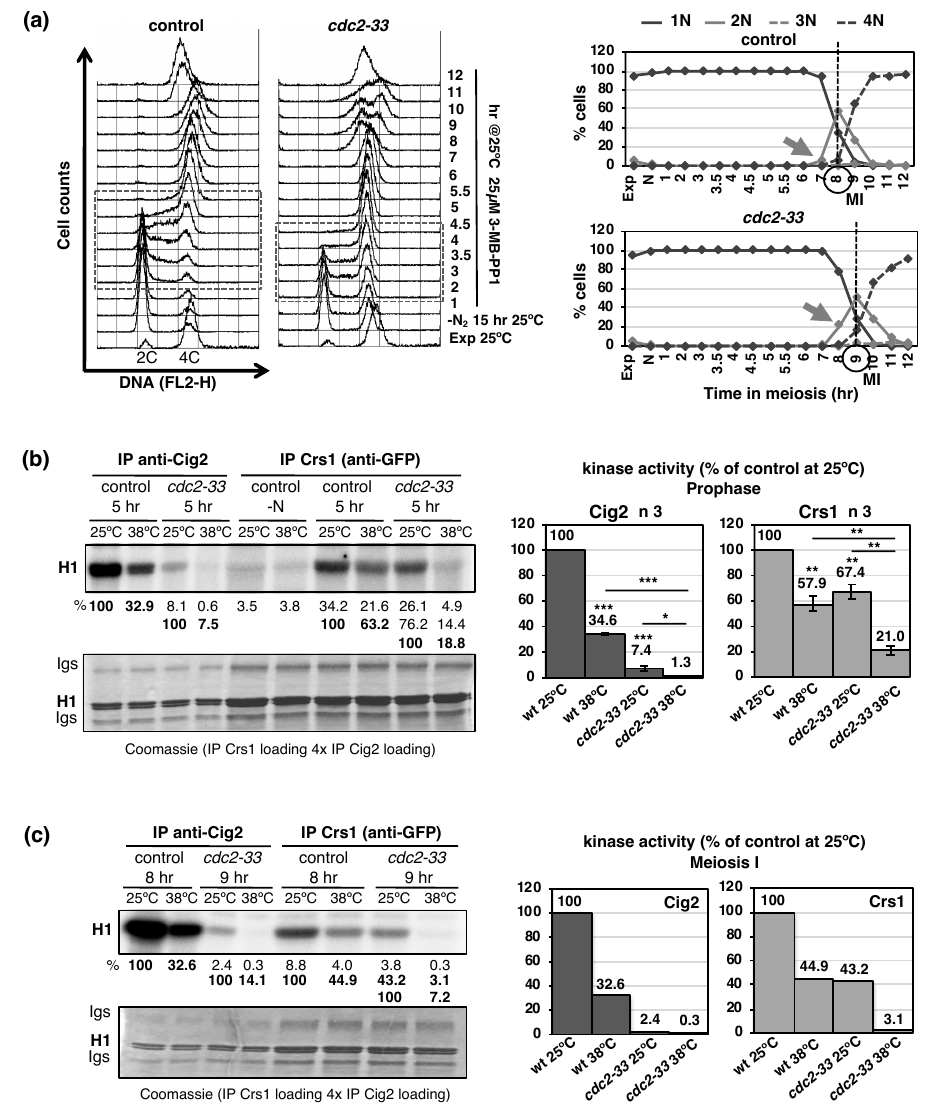
Figure 2. Crs1-GFP shows Cdc2-dependent kinase activity. ( a ) Flow cytometry analysis of synchronous diploid pat1- as1(L95G) crs1-GFP control (CMC1098) and cdc2-33 (CMC1109) meiosis at 25 ◦ C, 3-MB-PP1 ATP-analog added at the beginning of meiotic induction. DNA content (FL2-H) histograms are shown. Dashed-lined box outlines S-phase progression. On the right: Quantification of chromosome segregation by DAPI staining and nuclear counting (1 nucleus, 2 nuclei, 3 nuclei, and 4 nuclei) is shown. The arrows indicate meiosis I (MI) entry, and the vertical dashed-lines indicate the peak of MI. ( b ) In vitro kinase assays (histone H1 substrate) of Cig2 and Crs1-GFP immunoprecipitates (IP) at meiotic prophase (5 h after meiotic induction) of the synchronous diploid pat1-as1(L95G) crs1-GFP kinetics shown in ( a ). IPs were split in two just before the assay, and tested for kinase activity at 25 ◦ C and 38 ◦ C (permissive and restrictive temperature for cdc2-33 mutation). In the case of Crs1-GFP, cells at the beginning of the kinetics (nitrogen depleted, -N) were also collected as a control. The top panel shows phosphorimager scanning of the assays ran in an acrylamide gel, and percentages of activity. The bottom panel shows Coomassie staining of the same gel. Notice the 4-fold higher loading of the Crs1-GFP assays. Graphs on the right represent Cig2 and Crs1-associated prophasic-kinase activity as the mean of the percentage of activity relative to the cdc2 + control at 25 ◦ C +/ − SEM of 3 independent assays. The assays correspond to 2 replicates from 2 independent aliquots of frozen cells assayed in different days, and 1 replicate from a different time course. p value * < 0.05, ** ≤ 0.01, *** ≤ 0.001 (Student’s t -test, unpaired, two tails). ( c ) In vitro kinase assays (histone H1 substrate) of Cig2 and Crs1-GFP immunoprecipitates (IP) at meiosis I (8–9 h after meiotic induction). IPs were split in two just before the assay, and tested for kinase activity at 25 ◦ C and 38 ◦ C (permissive and restrictive temperature for cdc2-33 mutation). Similar data representation as in ( b ). Graphs on the right represent Cig2 and Crs1-associated kinase activity as the percentage of the activity observed in the cdc2 + control at 25 ◦